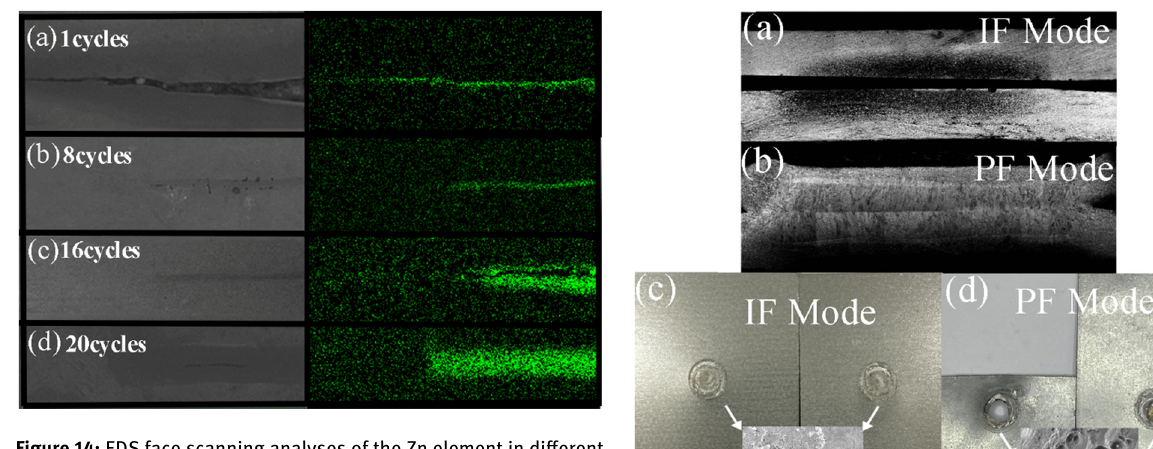
Figure 14: EDS face scanning analyses of the Zn element in di ff erent welding times: ( a ) 1 cycles, ( b ) 8 cycles, ( c ) 16 cycles, and ( d ) 20 cycles.